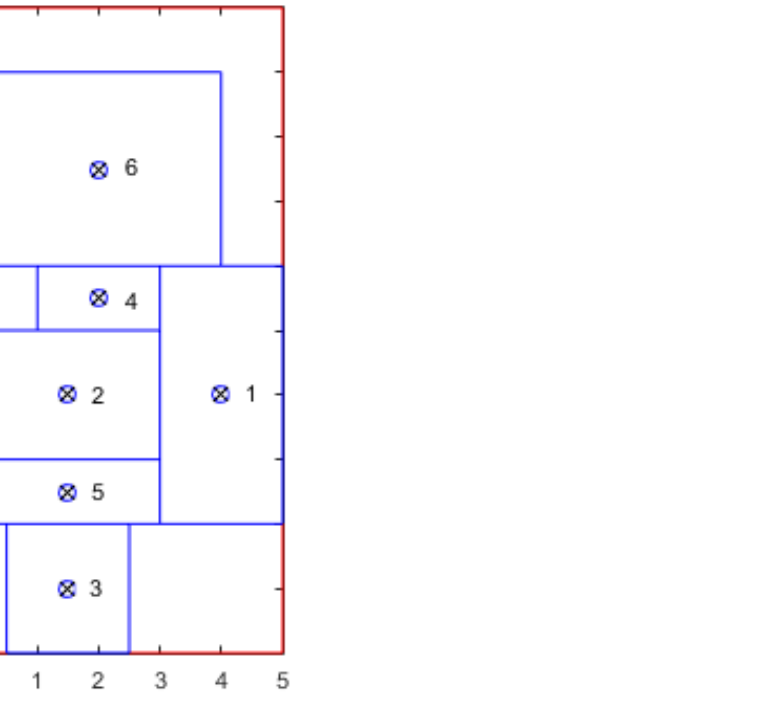
Figure 1. Optimal layout for small UA-FLP instance.